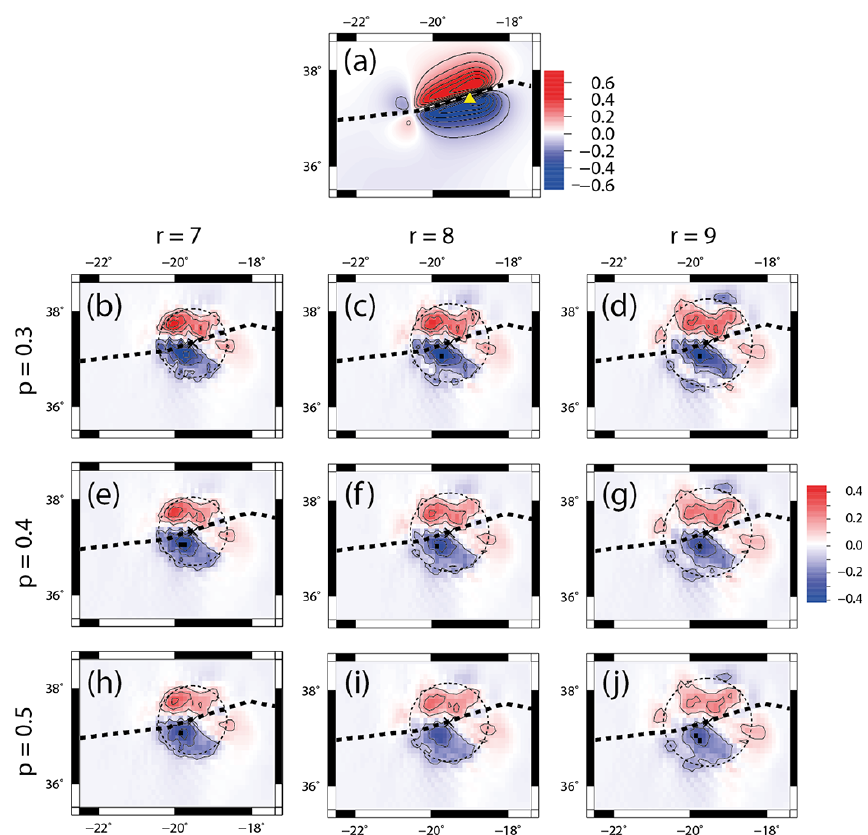
Figure 6. (a) Co-seismic deformation using the focal mechanism parameters proposed in this study: L is 170km, W is 45km; strike is 255 ◦ , rake is 161 ◦ , dip is 88 ◦ , slip is 8m, yellow triangle depicts epicentre; (b) – (j) initial displacement field of the 1941 Gloria Fault tsunami, obtained from waveform inversion for different values of r and p parameters; dashed line sketches the approximate location of the plate